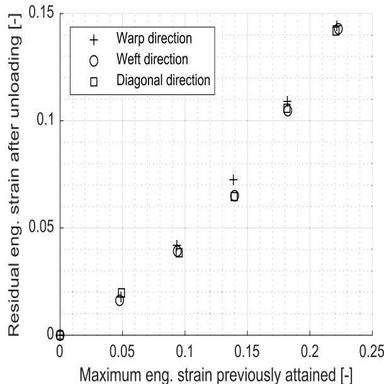
Permanent set evolution for uniaxial tensile tests as a function of maximum applied strain. The permanent set was derived as the residual strain obtained after unloading. The curves show that the evolution of the permanent set is similar in the warp, weft and diagonal directions.